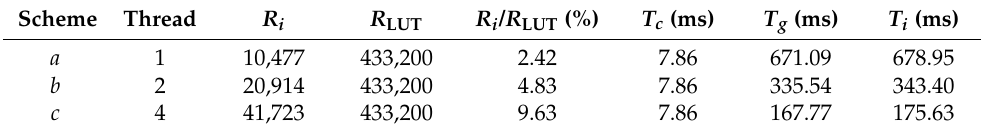
Table 2. Resource usage and theoretical calculation time in interferogram generation with different threads.